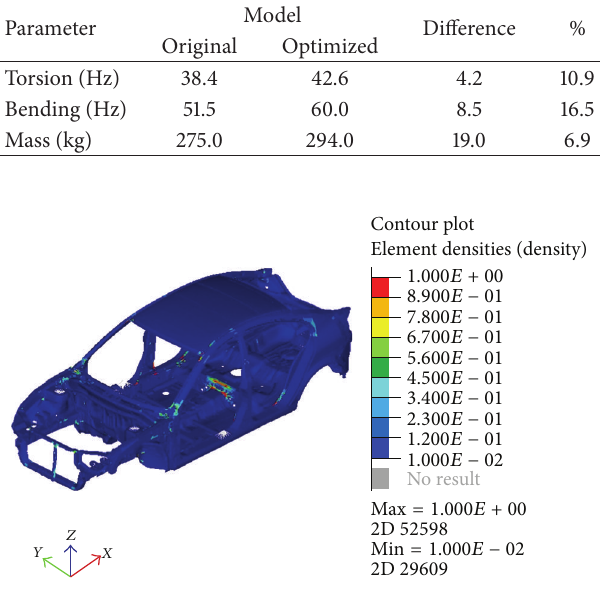
Figure 6: Optimization result by element